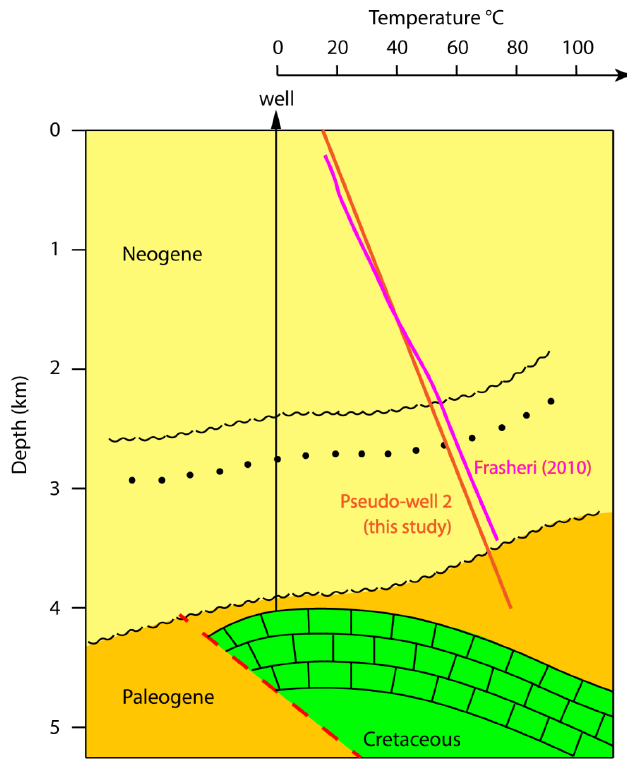
Figure 10. Temperature profile for the Peri-Adriatic Depression from Frasheri [49] modified and compared with the geotherm obtained in this study for a similar structural setting along strike (pseudo-well 2, located in Figure 6). The top of the carbonates (green) is shallower with respect to that shown in the geological section of this study (Figure 4) due to the northward plunge of the structures.